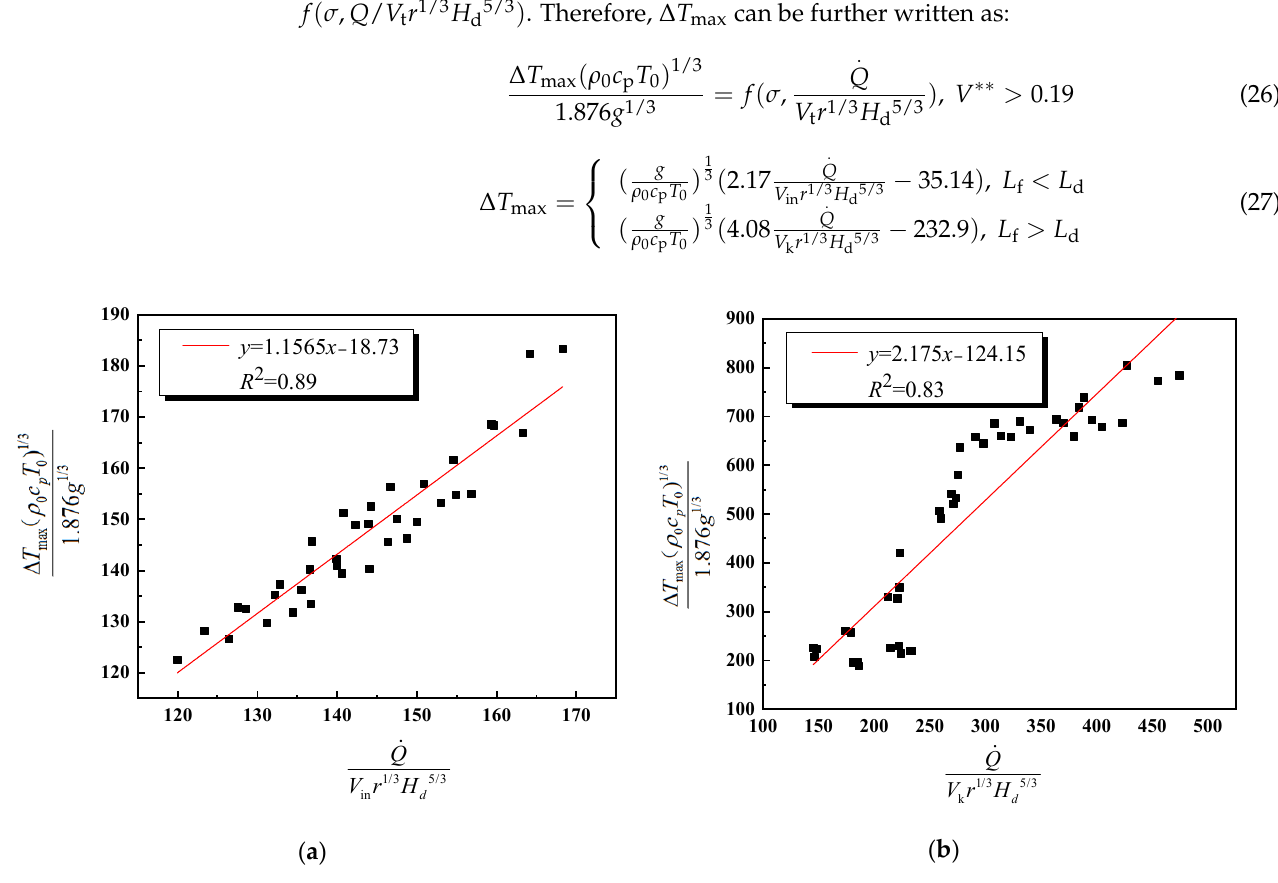
Figure 17. Fi tt ing relation of max T and Q ( a ) L f ≤ 330, ( b ) L f > 330. Figure 18 shows that the prediction results are in good agreement with the simulation results, and the error range is less than 20%.